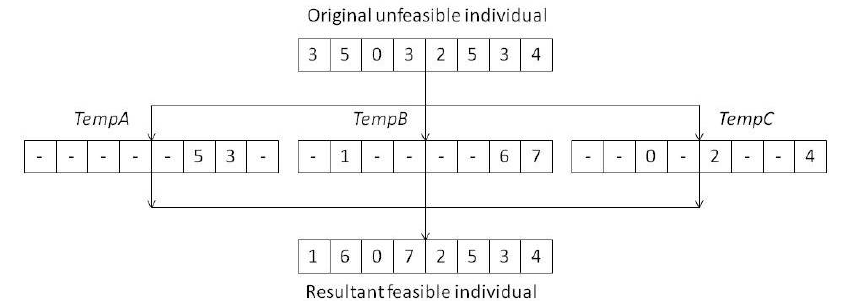
Figure 2. An example of the viability operation.